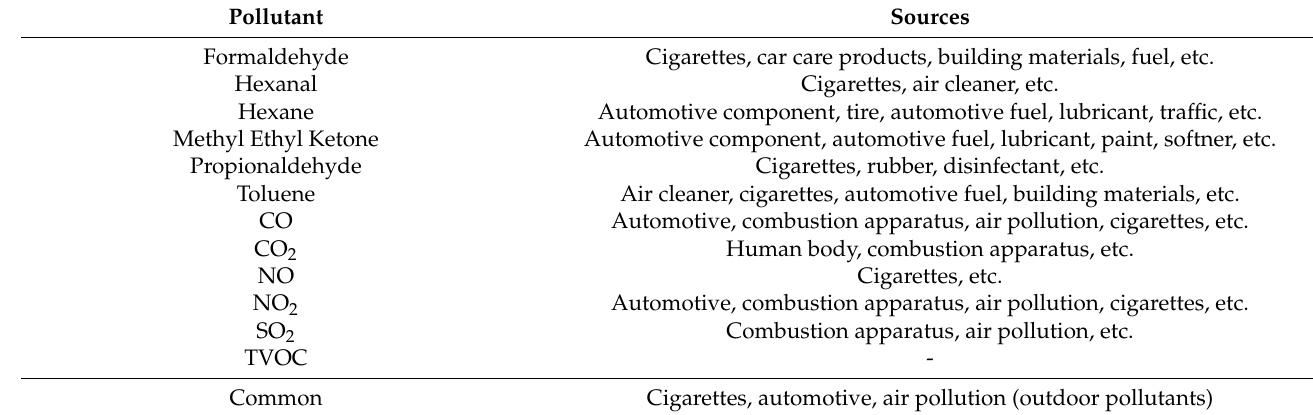
Table 8. Sources of pollutants in the first principal component (PC1). TVOC—total volatile organic compounds. Pollutant